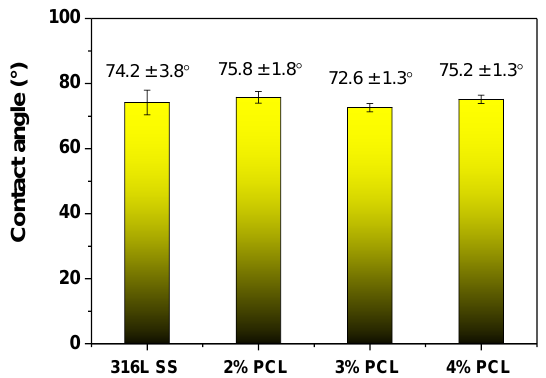
Figure 2. The water contact angles of the bare 316L SS and the 316L SS coated with 2, 3, and 4% PCL films.